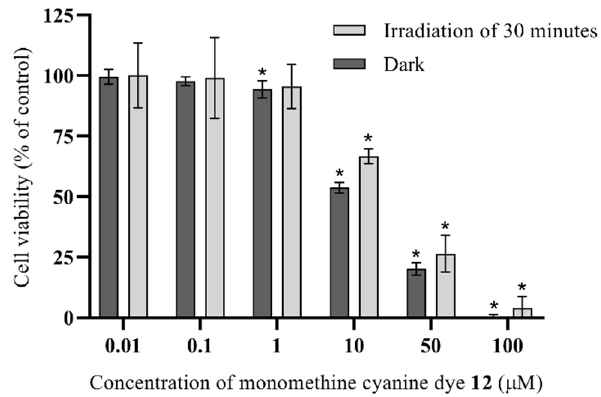
Figure 3. In vitro photocytotoxic effects of the monomethine cyanine dye 12 on the relative cell viability of normal human dermal fibroblasts (NHDF). Exposure to the dye 12 was evaluated after 72 h of incubation in the dark and after irradiation with an LED system. For this assay, NHDF cells were incubated for 48 h with the dye 12 at different concentrations and then exposed to white light from a 30 W RGB LED system for 30 min. Cell viability was evaluated 24 h after irradiation using an MTT assay. The results are expressed as the average value ± standard deviation of two independent assays performed in quadruplicate. A p < 0.05 versus the negative control in the statistical significance analysis (Student’s t -test) was observed for the treatments that are denoted with a signal (*).